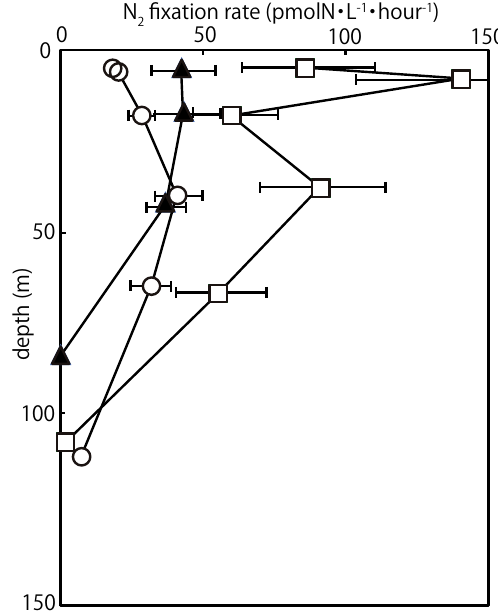
Fig. 2. Depth profiles of N 2 fixation rates in the particulate fraction during the KH06-2 expedition at Stns. 1, 6, and 7 (denoted by tri- angles, circles, and squares, respectively). The error bars represent the standard deviations for the triplicate water